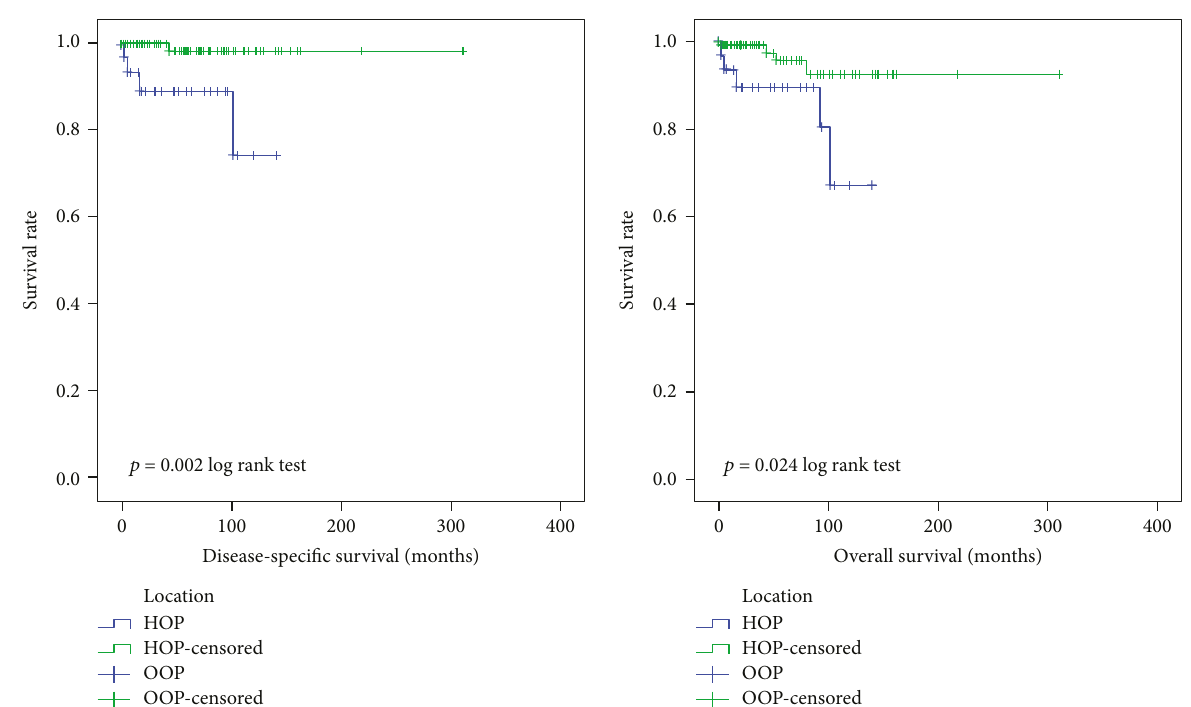
Figure 1: The DSS and OS K-M curves of SEER cohort according to the classi fi cation of